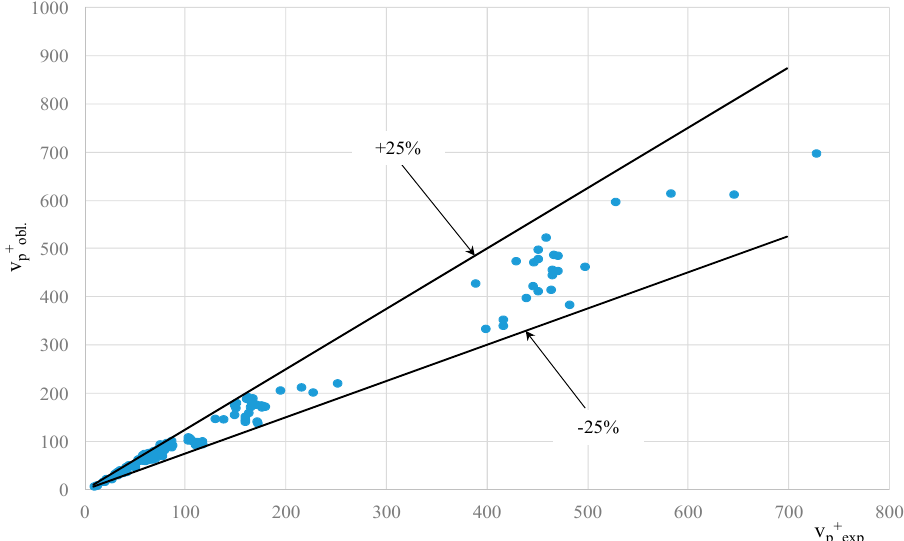
Figure 8. Dependence of dimensionless velocity v + p . reg obtained by dimensional analysis on the value obtained in experimental studies v + p .exp for